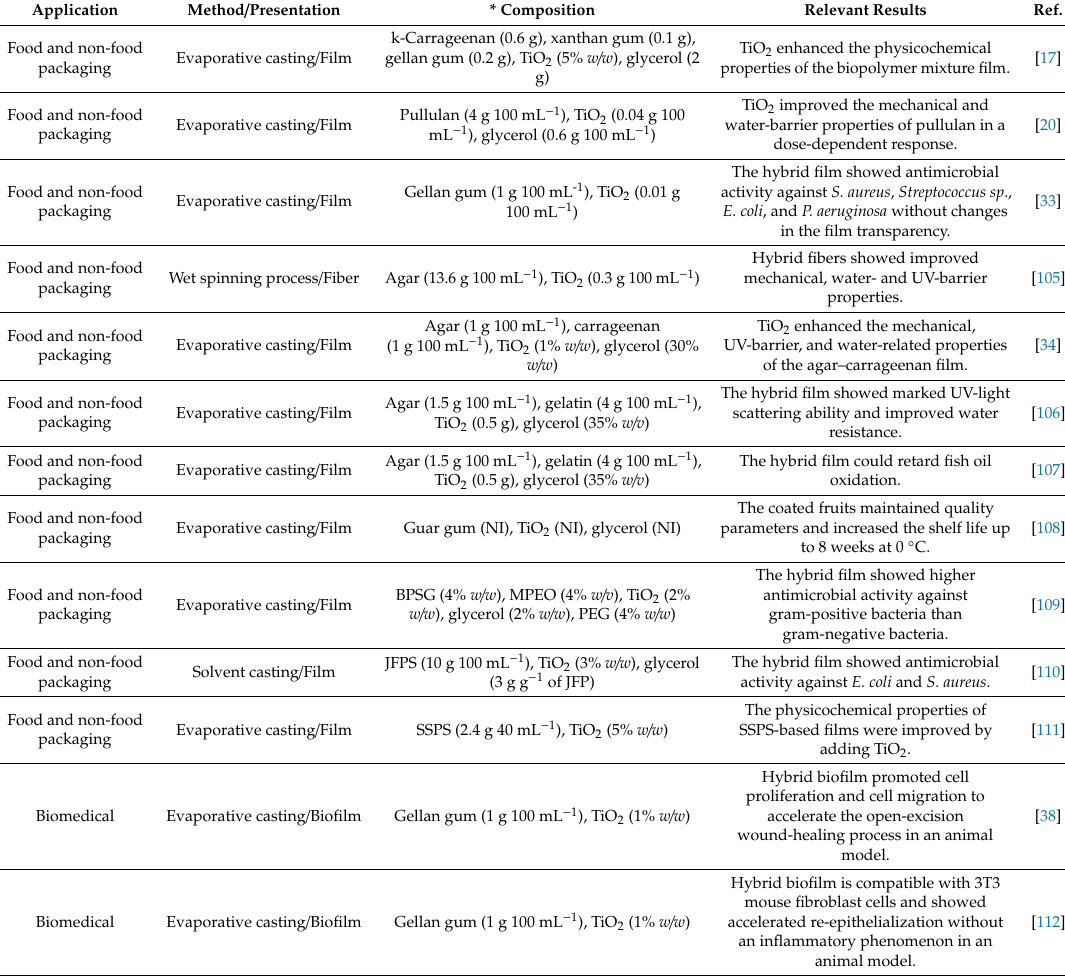
Table 5. E ff ect of TiO 2 incorporation on nonconventional polysaccharide-based materials